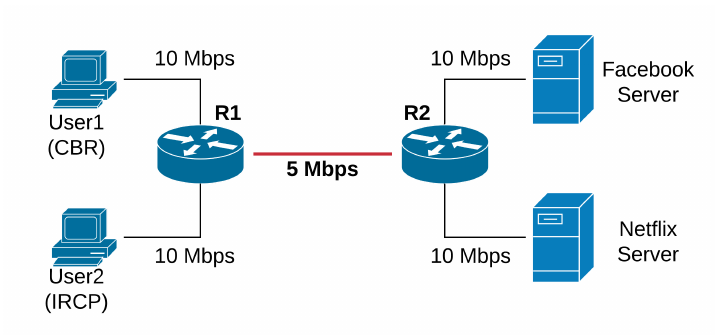
Figure 3. Dumbbell topology with 5 Mbps bottleneck